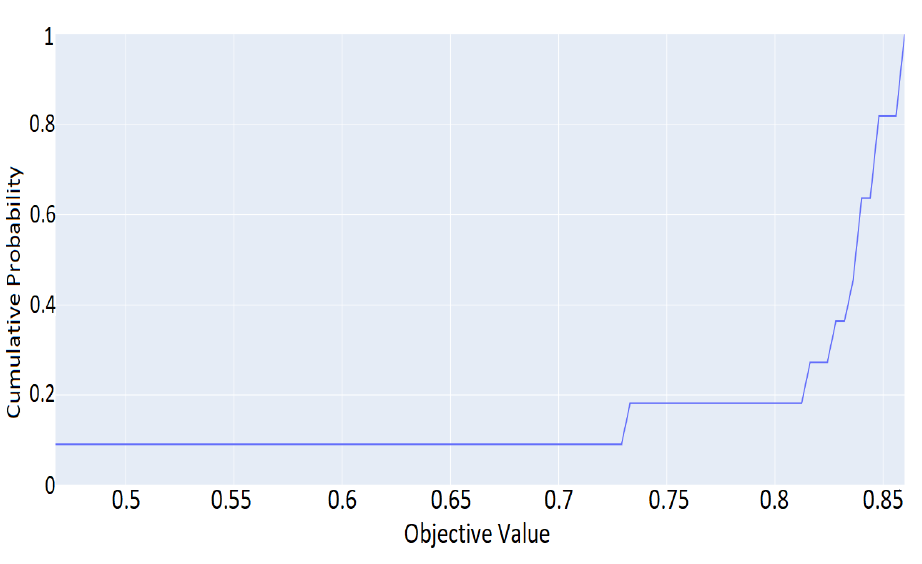
Figure 9. Cumulative probability distribution of the DNN model.